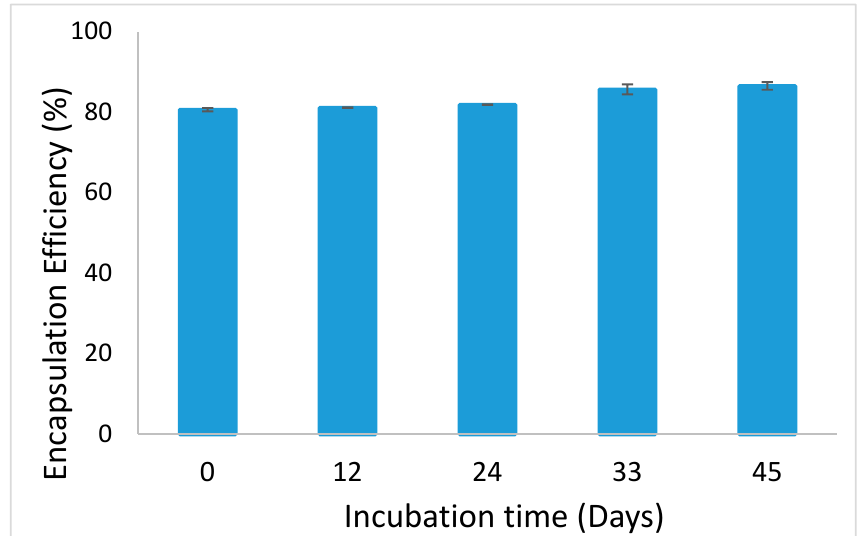
Figure 1. Encapsulation efficiency of medium-sized iron-loaded alginate beads followed in time.